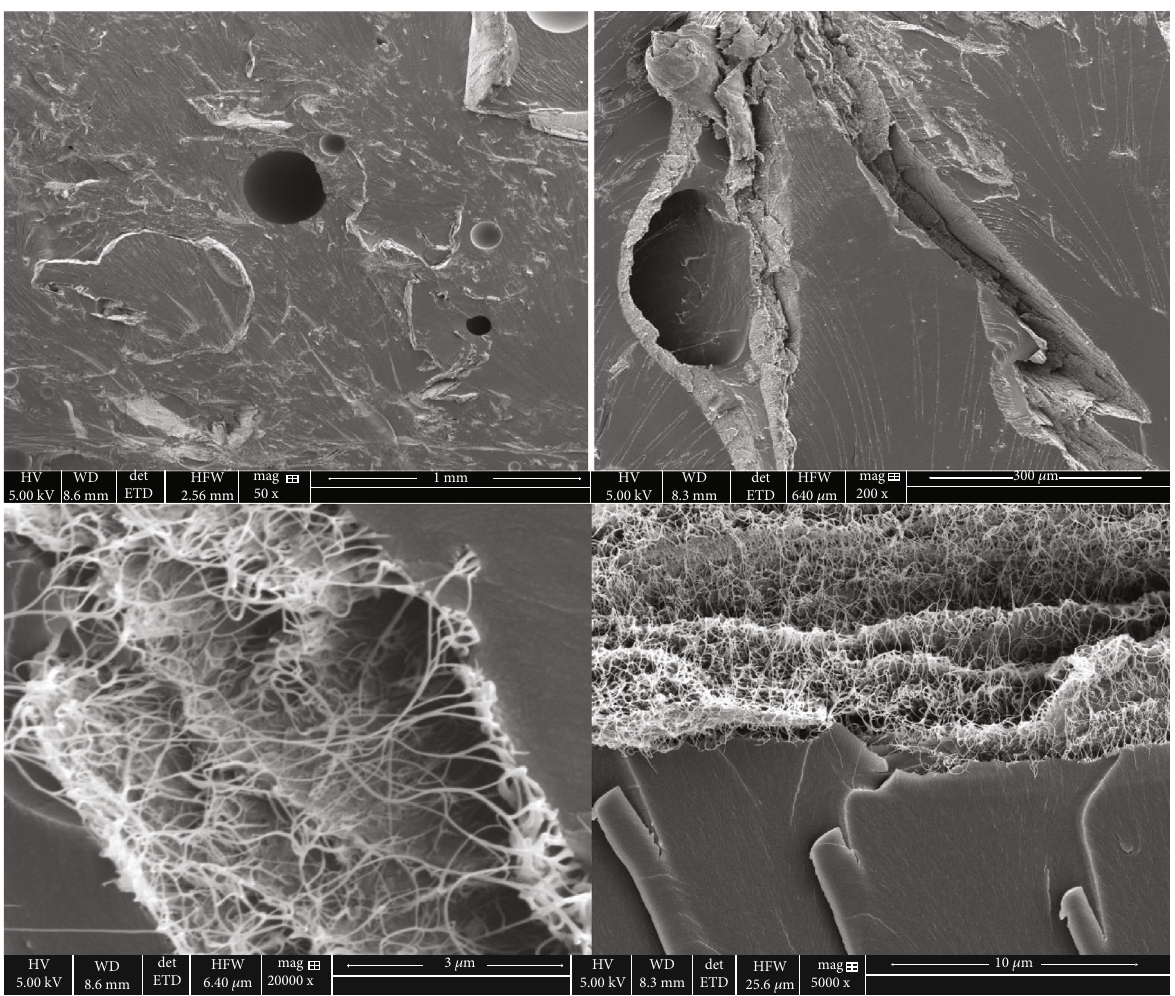
Figure 21: Fracture surfaces in a 1.5 wt.% SWCNT-reinforced epoxy composite subjected to 3000 thermal